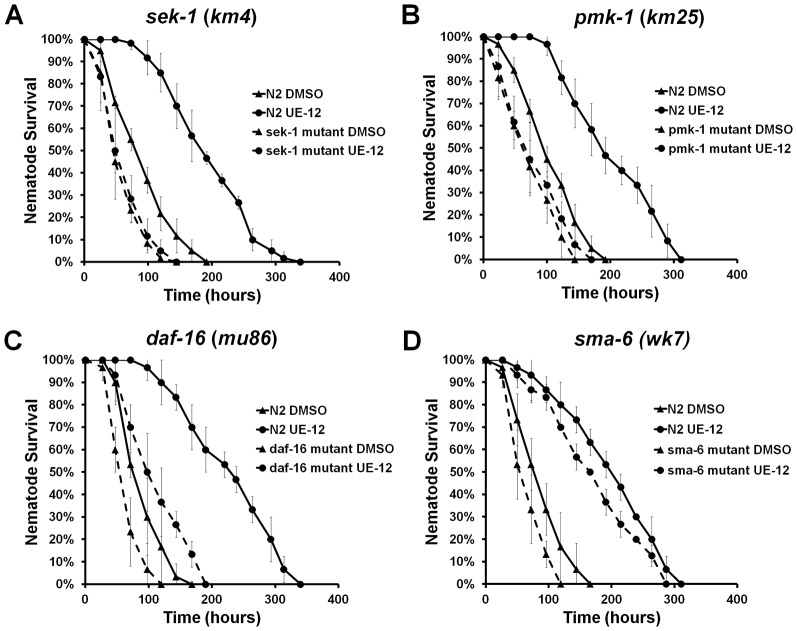
UE-12 requires the C. elegans p38 MAP kinase and insulin-like signaling pathways to confer its full protective effect.The survival curves of wild-type N2 and (A) sek-1 (km4) mutant animals, (B) pmk-1 (km25) mutants, (C) daf-16 (mu86) mutants and (D) sma-6 (wk-7) mutants following treatment with UE-12 or DMSO. The effect of UE-12 is diminished in sek-1 (km4) and pmk-1 (km25) mutants whilst partially attenuated in daf-16 (mu86) mutants. In sma-6 (wk7) mutants, UE-12 demonstrated a similar effect as in wild-type N2 animals (p<0.0001). Data at each time point are the average of six wells with each well containing 20 animals per well. Data are representative of three independent experiments.